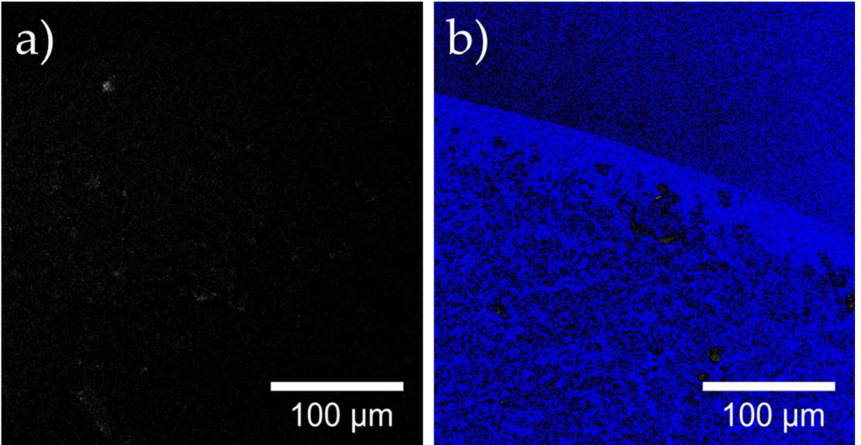
Figure 6. Confocal images using two excitation lasers 559 nm and 633 nm at 20 × of ( a ) magnetite and ( b ) Laccase-magnetite. Images combined the optical image of both excitations.